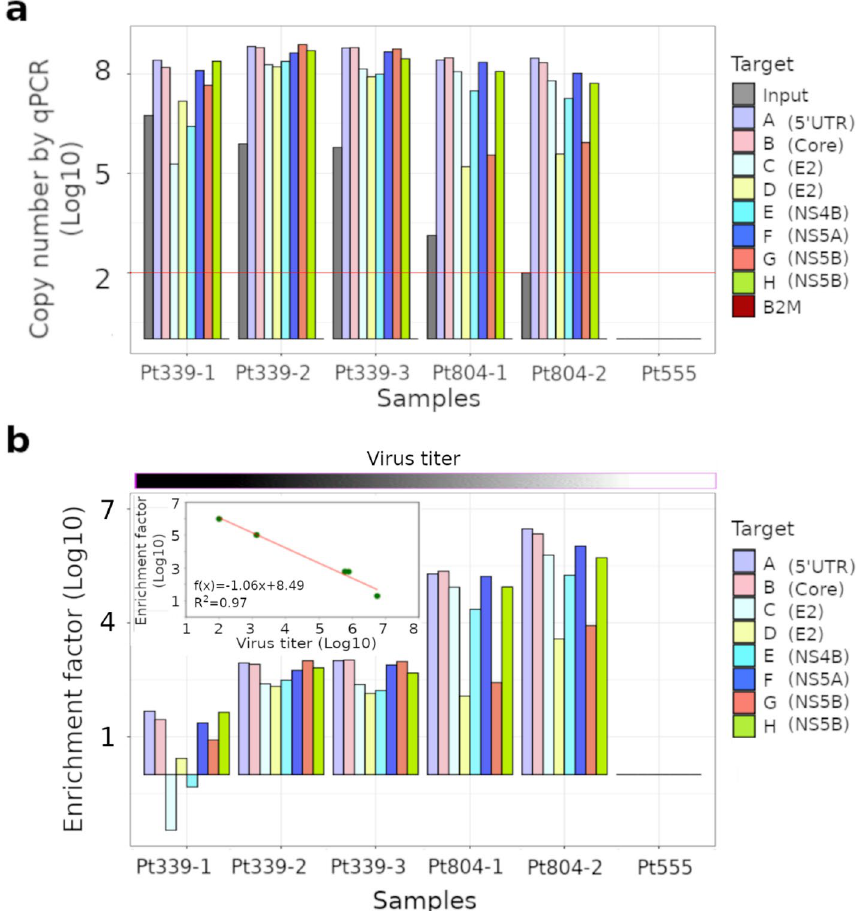
Figure 4. Evaluation on plasma of HCV-infected patients. The same 8 regions from Fig. 3 were targeted on five HCV patient samples and one negative control. ( a ) Measured copy numbers were zero for all target regions in the HCV-negative (Pt555) sample, and the B2M gene in all HCV-positive samples. Red line indicates the detection limit of qPCR. ( b ) Enrichment factor is the ratio of copy numbers before and after capture. This is shown as a function of sample (main plot) and viral titer (inset). One sample (Pt804-2) was below the qPCR limits of detection, but known to be HCV-positive because the patient had a relapse. Nonetheless, InBeads capture was able to detect all 8